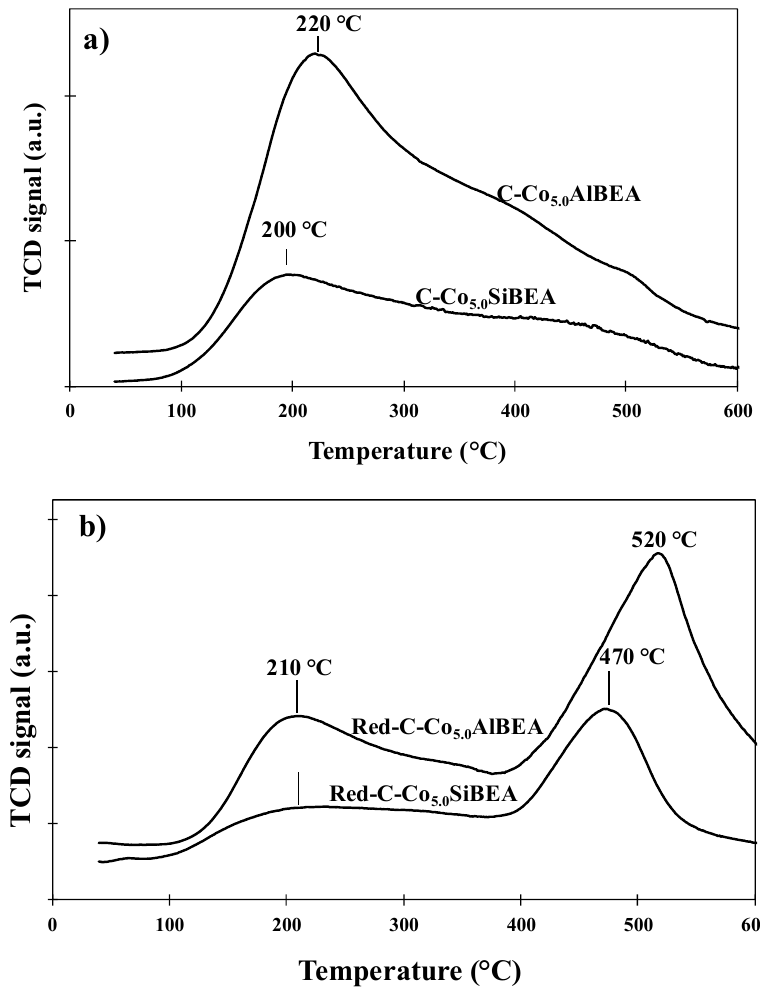
Figure 6. TPD-NH 3 patterns for C-Co 5.0 AlBEA and C-Co 5.0 SiBEA ( a ) and Red-C-Co 5.0 AlBEA and Red-C-Co 5.0 SiBEA reduced in H 2 at 500 °C for 1 h ( b ).